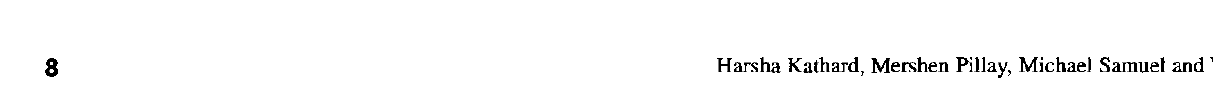
Table 2: Incidents and events leading to the initial discovery of self as different Participants Critical events and primary contexts